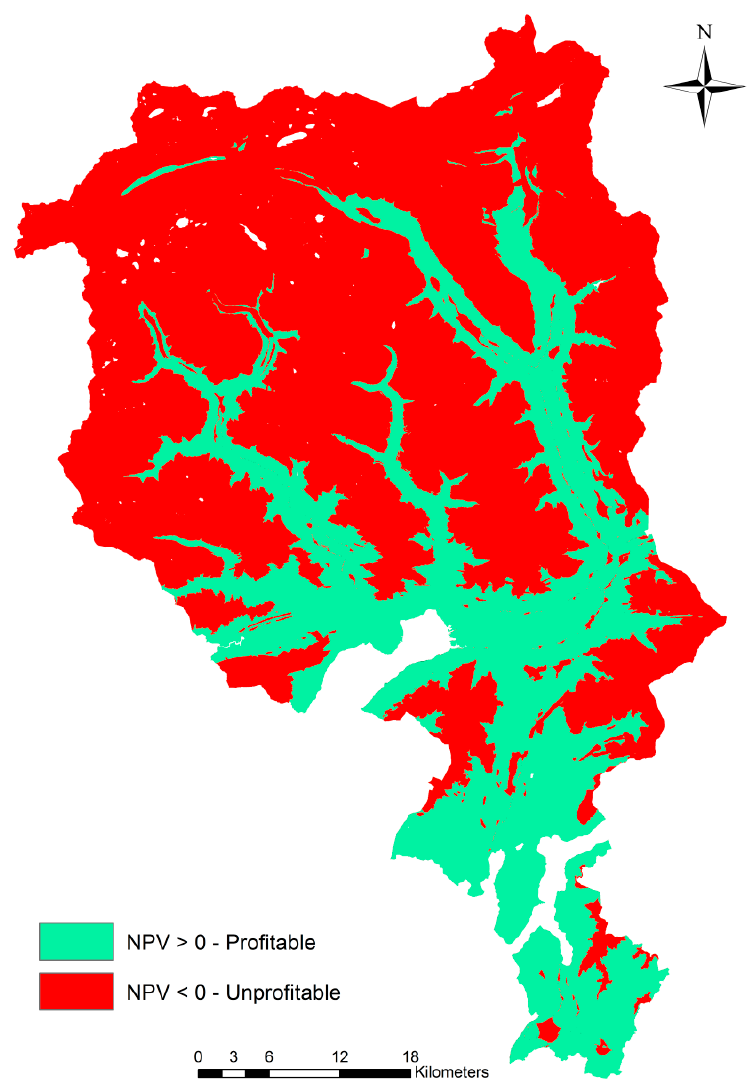
Figure 8. Map of profitability of the investment calculated for an economic analysis of 25 years. The areas where the investment would be profitable considering a discount rate of 3% (the return that could be earned per unit of time on an investment with similar risk) are reported in green. Red portion are zones where the investment in a closed-loop system would not be profitable, considering the NPV.